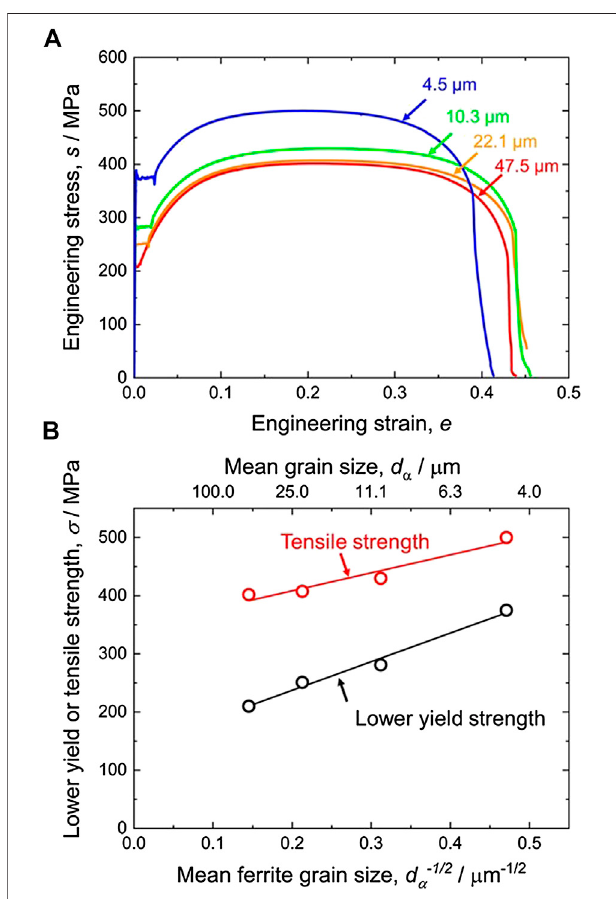
FIGURE 9 | (A) Engineering stress-strain curves of the F + P specimens with different ferrite grain sizes ranging from 47.5 to 4.5 μ m. (B) The yield strength ( σ Y : the lower yield stress) and the tensile strength ( σ TS ) of the F + P specimens plotted as a function of the minus square root of the average ferrite grain size (Hall-Petch